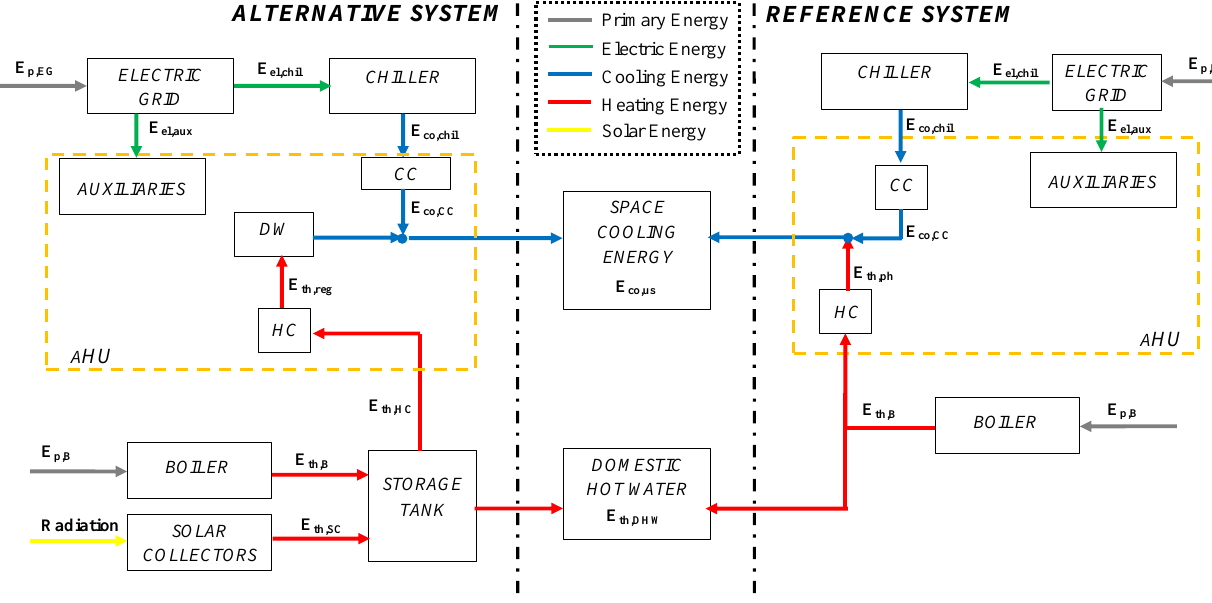
Figure 2. Energy flows during summer with active AHU: alternative system (scenarios B and C, flat-plate and evacuated tube collectors, respectively) and reference